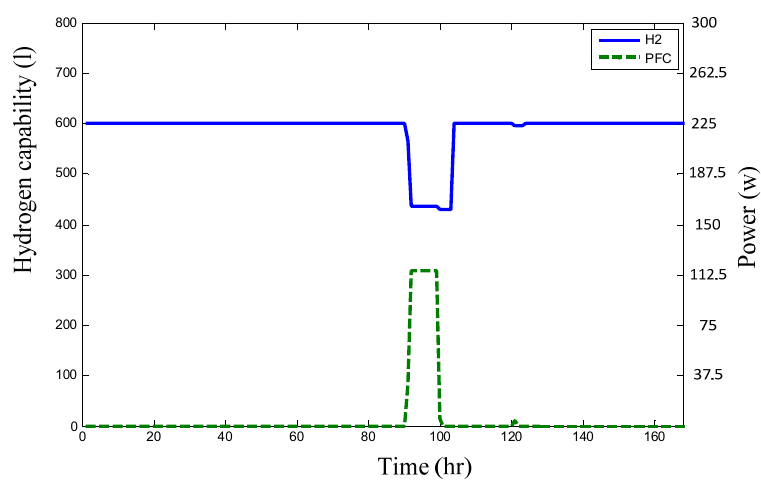
Figure 9. The curves of the hydrogen capability and fuel cell power in the first week of December.